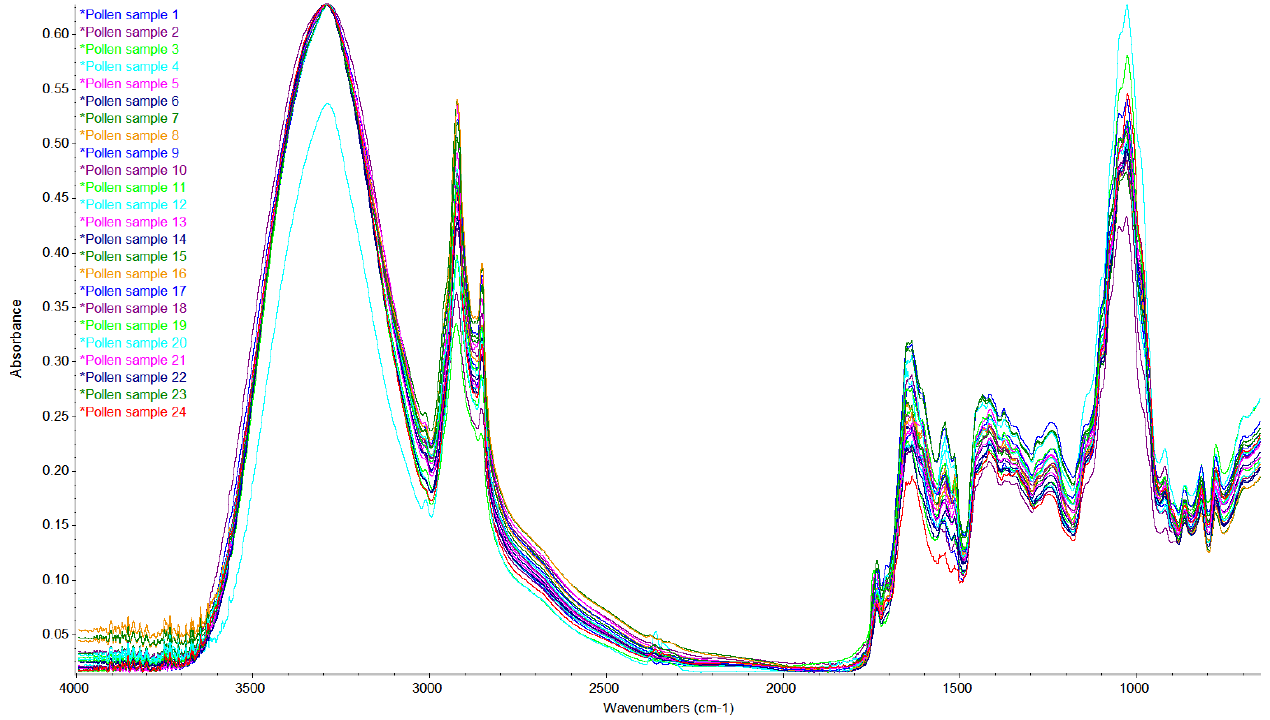
Figure 1. Bee pollen FT-IR spectra in the region 4000 – 650 cm −1 .